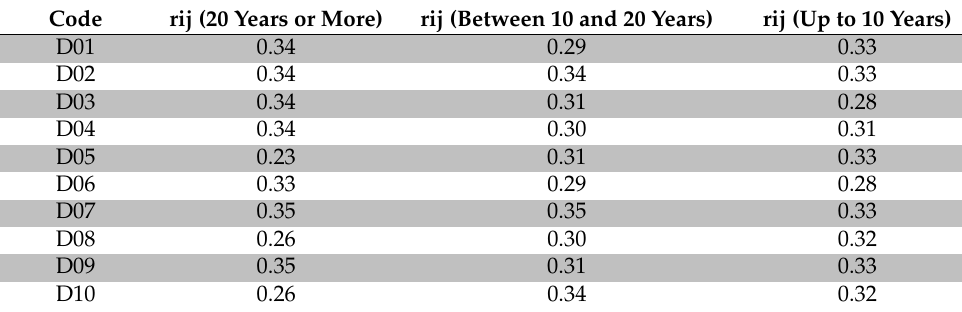
Table 4. Matrix R with normalized values.